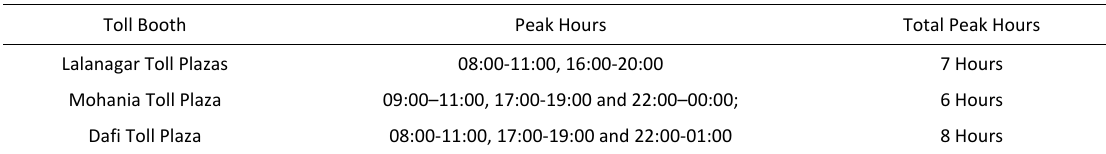
Table 1: Vehicle peak hours at the three toll booths